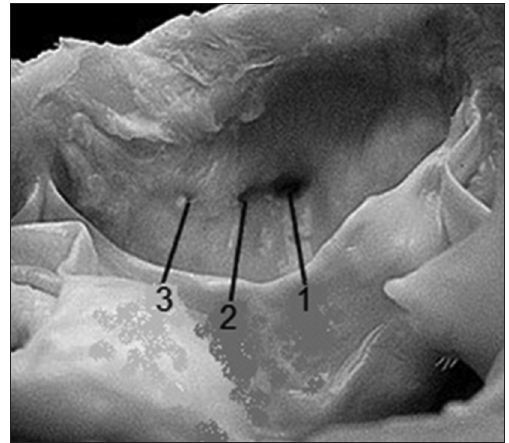
FIGURE 4. Right coronary artery (RCA) orifice and supernumerary artery orifices in right aortic sinus (1. RCA, 2. third coronary artery, and 3. fourth coronary artery).